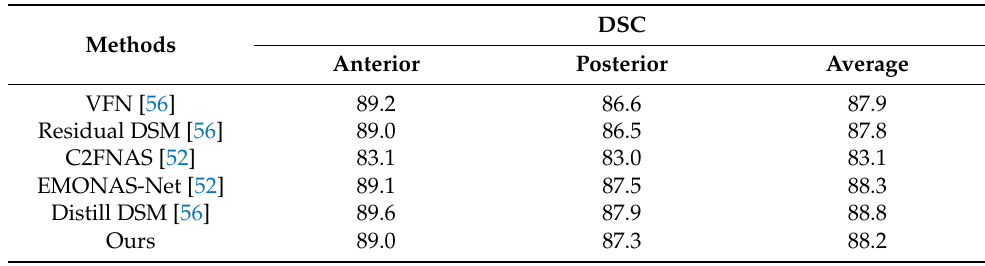
Table 6. Quantitative evaluation of different networks for the hippocampus dataset in terms of DSC